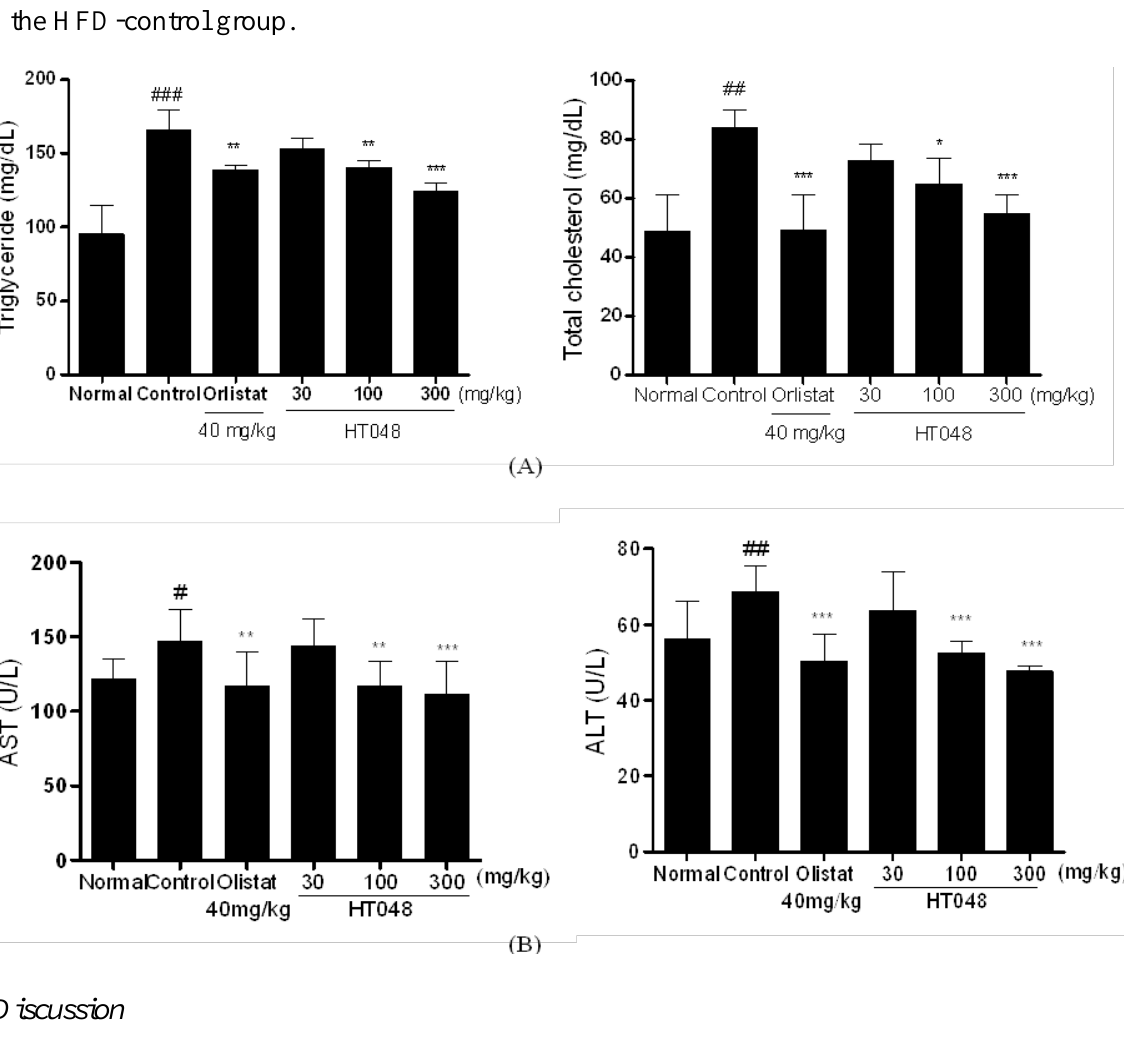
Figure 5. ( A ) Effects HT048 on serum triglyceride and total cholesterol, ( B ) and AST and ALT concentrations in HDF induced obese rat. At the end of the treatment period, blood sample was collected via abdominal aorta. Serum triglyceride (TG), total cholesterol (TC), ALT, and AST concentrations were measured by biochemical analyzer. Data are mean ± SD values (n = 10 per group). # p < 0.05, ## p < 0.01, ### p < 0.001, significant difference from the normal diet group. * p < 0.05, ** p < 0.01, *** p < 0.001, significant difference